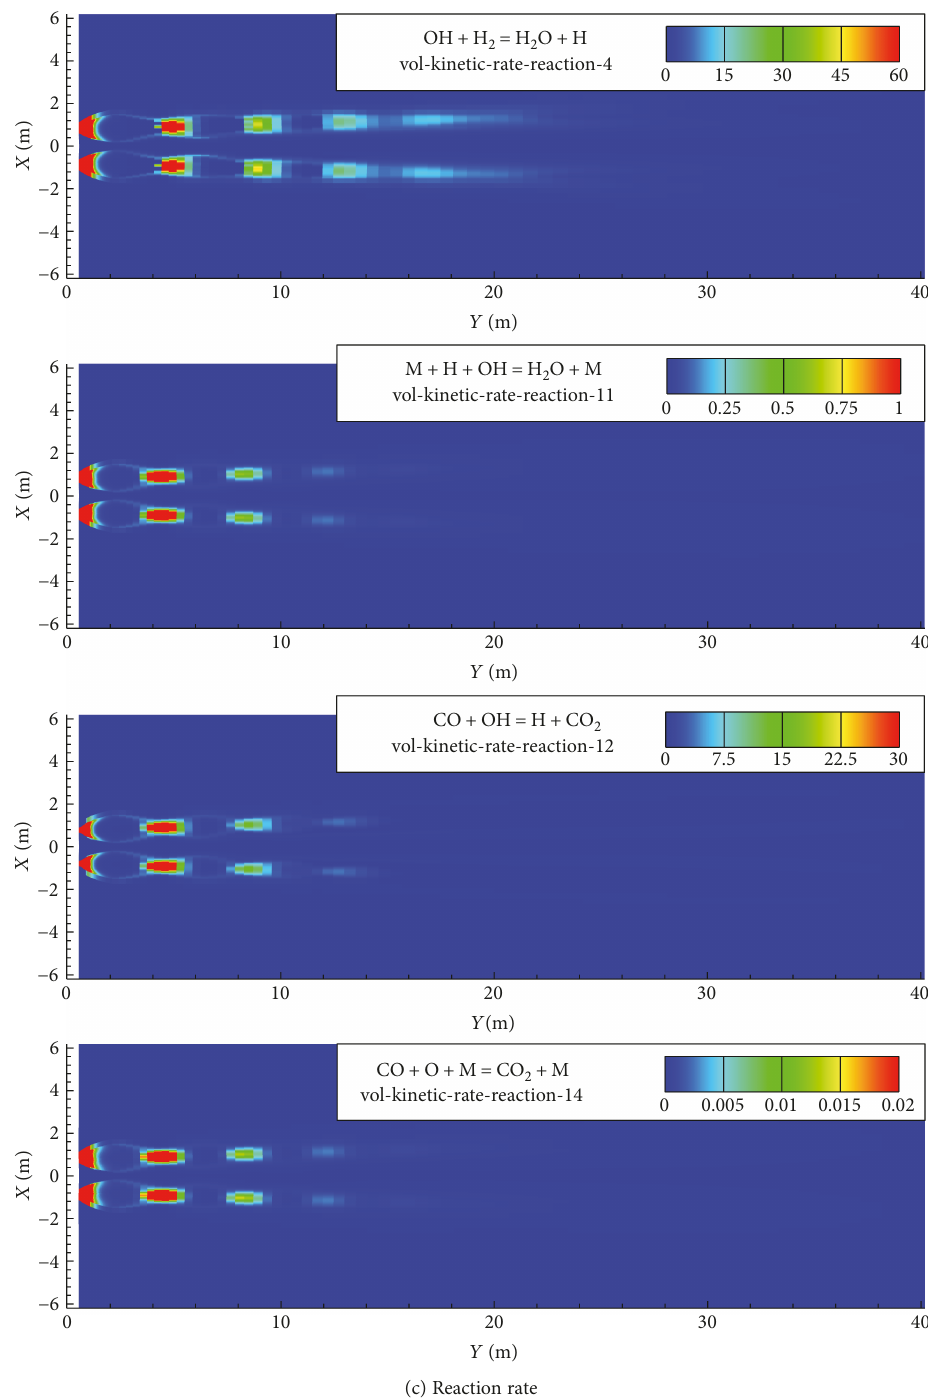
Figure 10: Plume fl ow fi elds of the double-nozzle engine